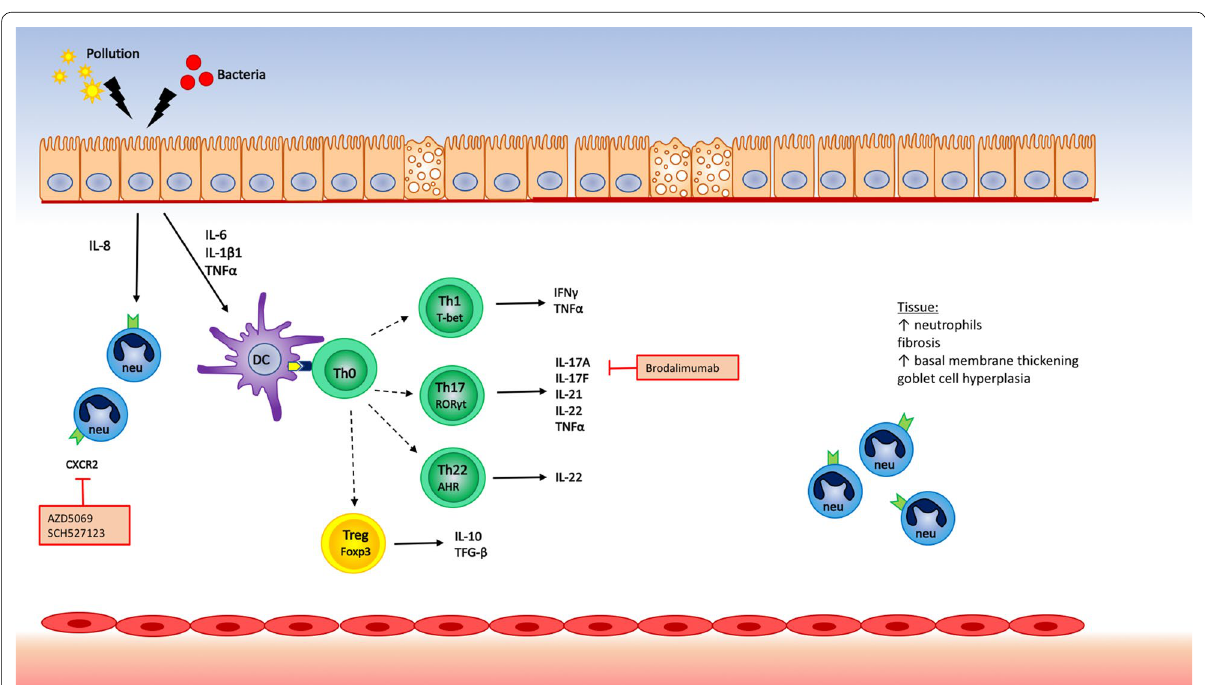
Fig. 3 Non-type 2 inflammation and biological. None-type 2 hosts different T helper subsets. Th1 cells, Th17 and Th22 cells characterized by their individual transcription factors (T-bet, RORyt, AHR) are responsible for Th1, Th17 and Th22 cytokines respectively. Regulatory T cells suppress the immune response via production of IL-10 and TGF-β. DC dendritic cell; neu neutrophils; Th T helper cell; Treg T regulatory